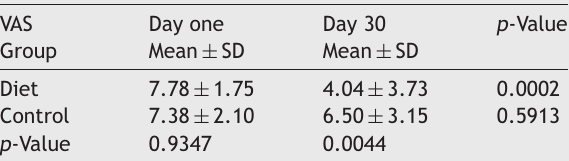
VAS values in the DG and CG on day one and day 30. VAS Day one Day 30 p